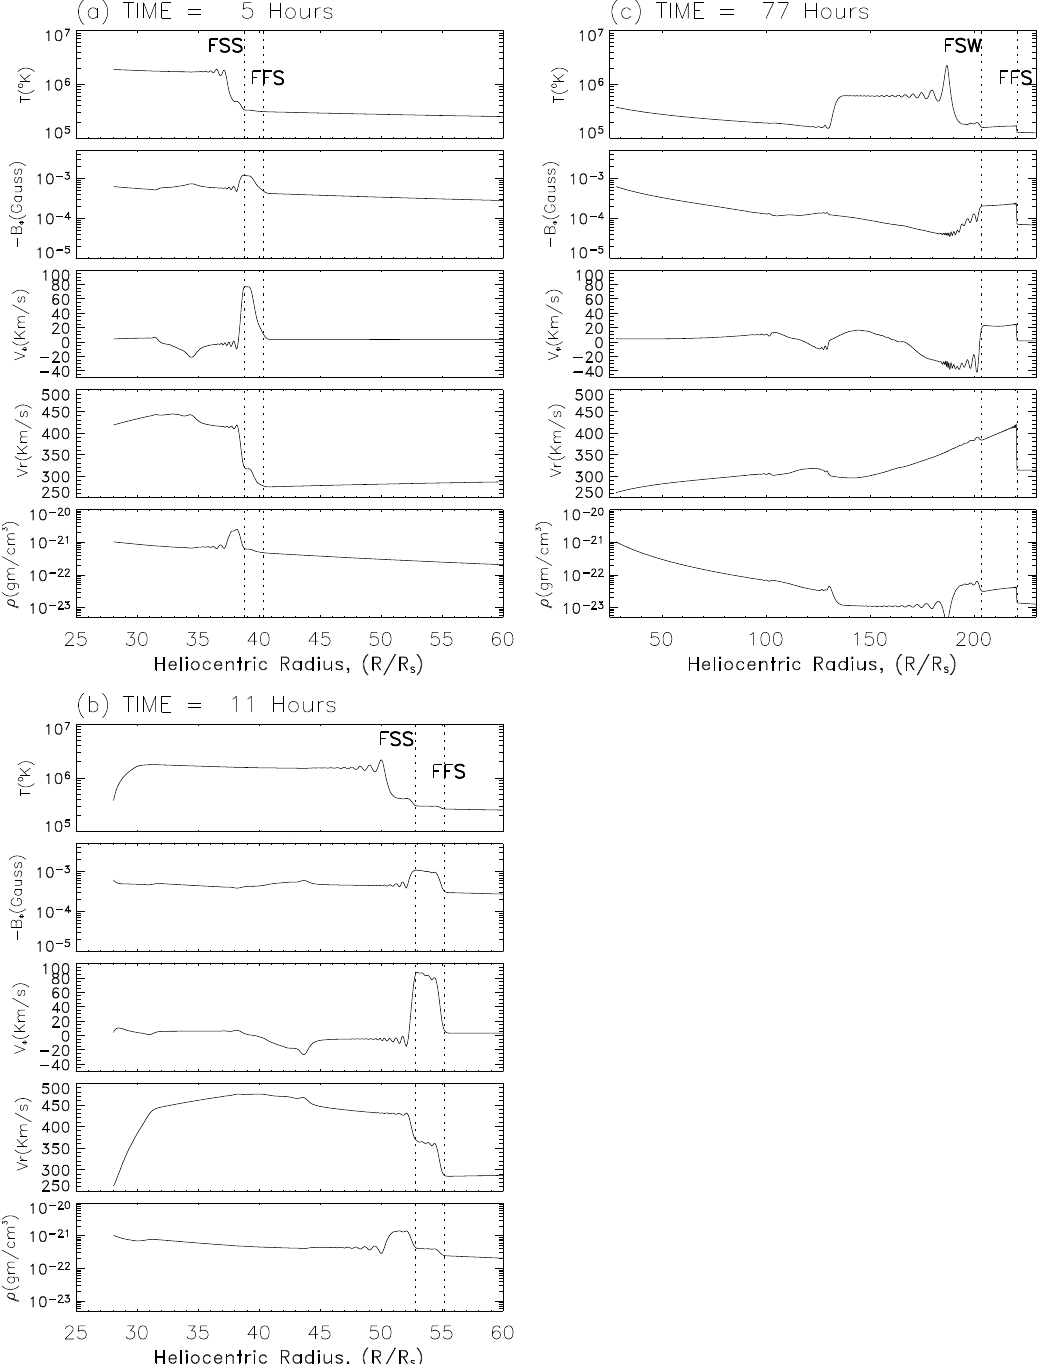
Figure 3. Solar wind solution versus heliocentric distance for Case 2: Fig. 3. Solar wind solution versus heliocentric distance for Case 2: v heliocentric distance for t=5, 11 and 77h. Note that non-physical oscillations linked to the use of the Lax-Wendroff scheme are found behind the fast slow wave,